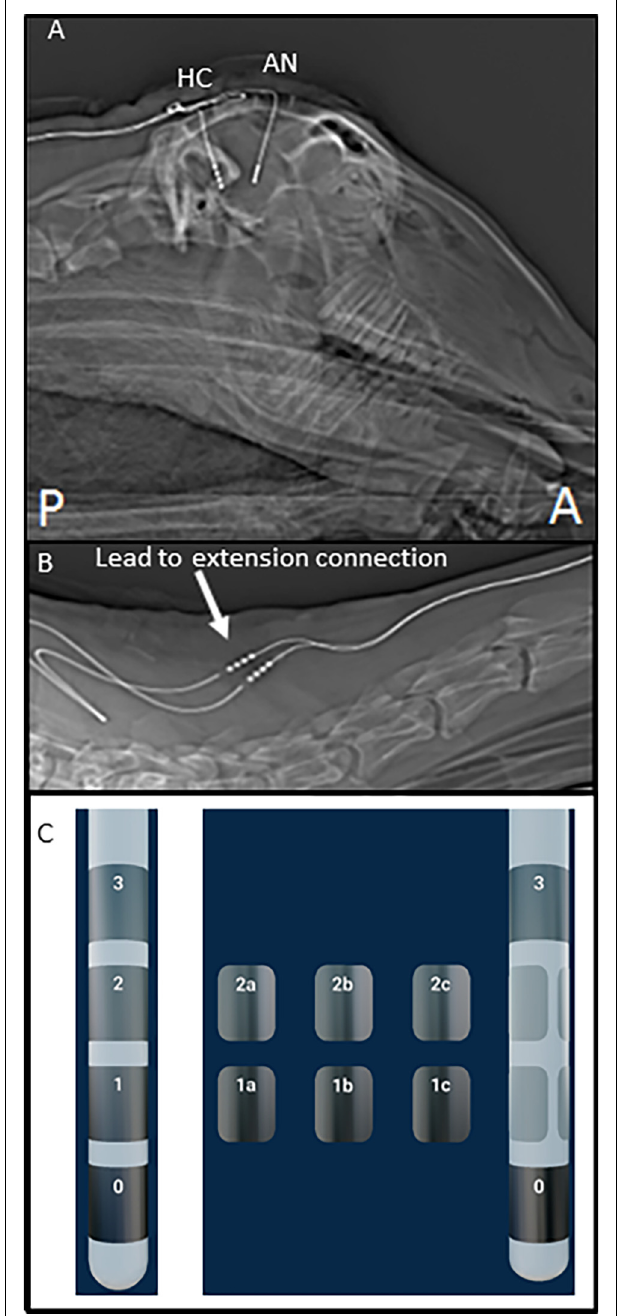
FIGURE 1 | Post-operative images of deep brain stimulation (DBS) implant. (A) Top panel shows the sagittal X-ray image of the head of one subject with DBS leads in place. (B) This panel illustrates the position of lead-extension connector (arrow) at the base of the neck, near the junction of cervical, and the thoracic spine. (C) This panel illustrates the two lead types used in this testing and electrode